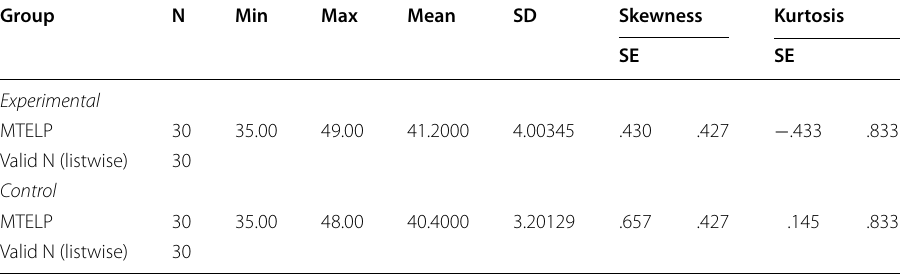
Table 2 Descriptive statistics